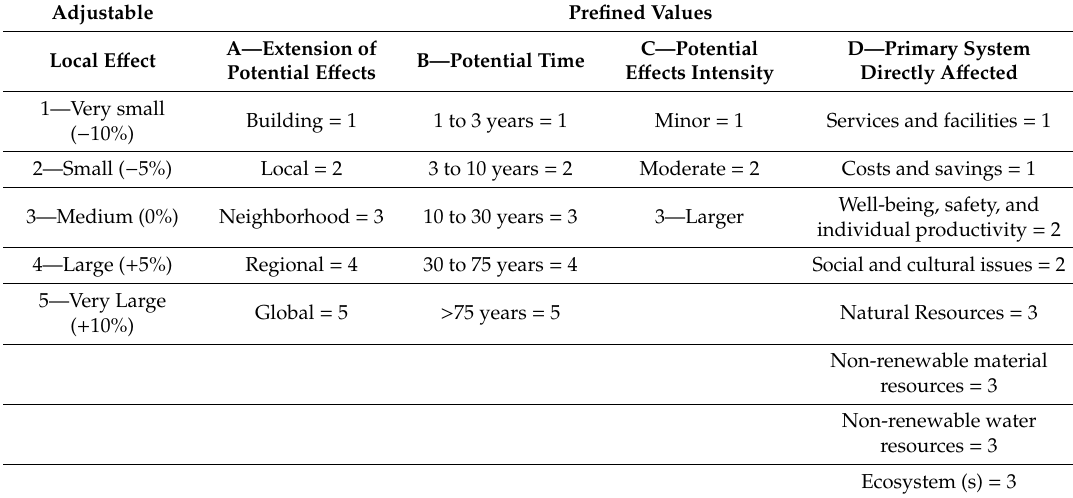
Table 3. Definition of the indicators’ weights according to the characteristics of the project